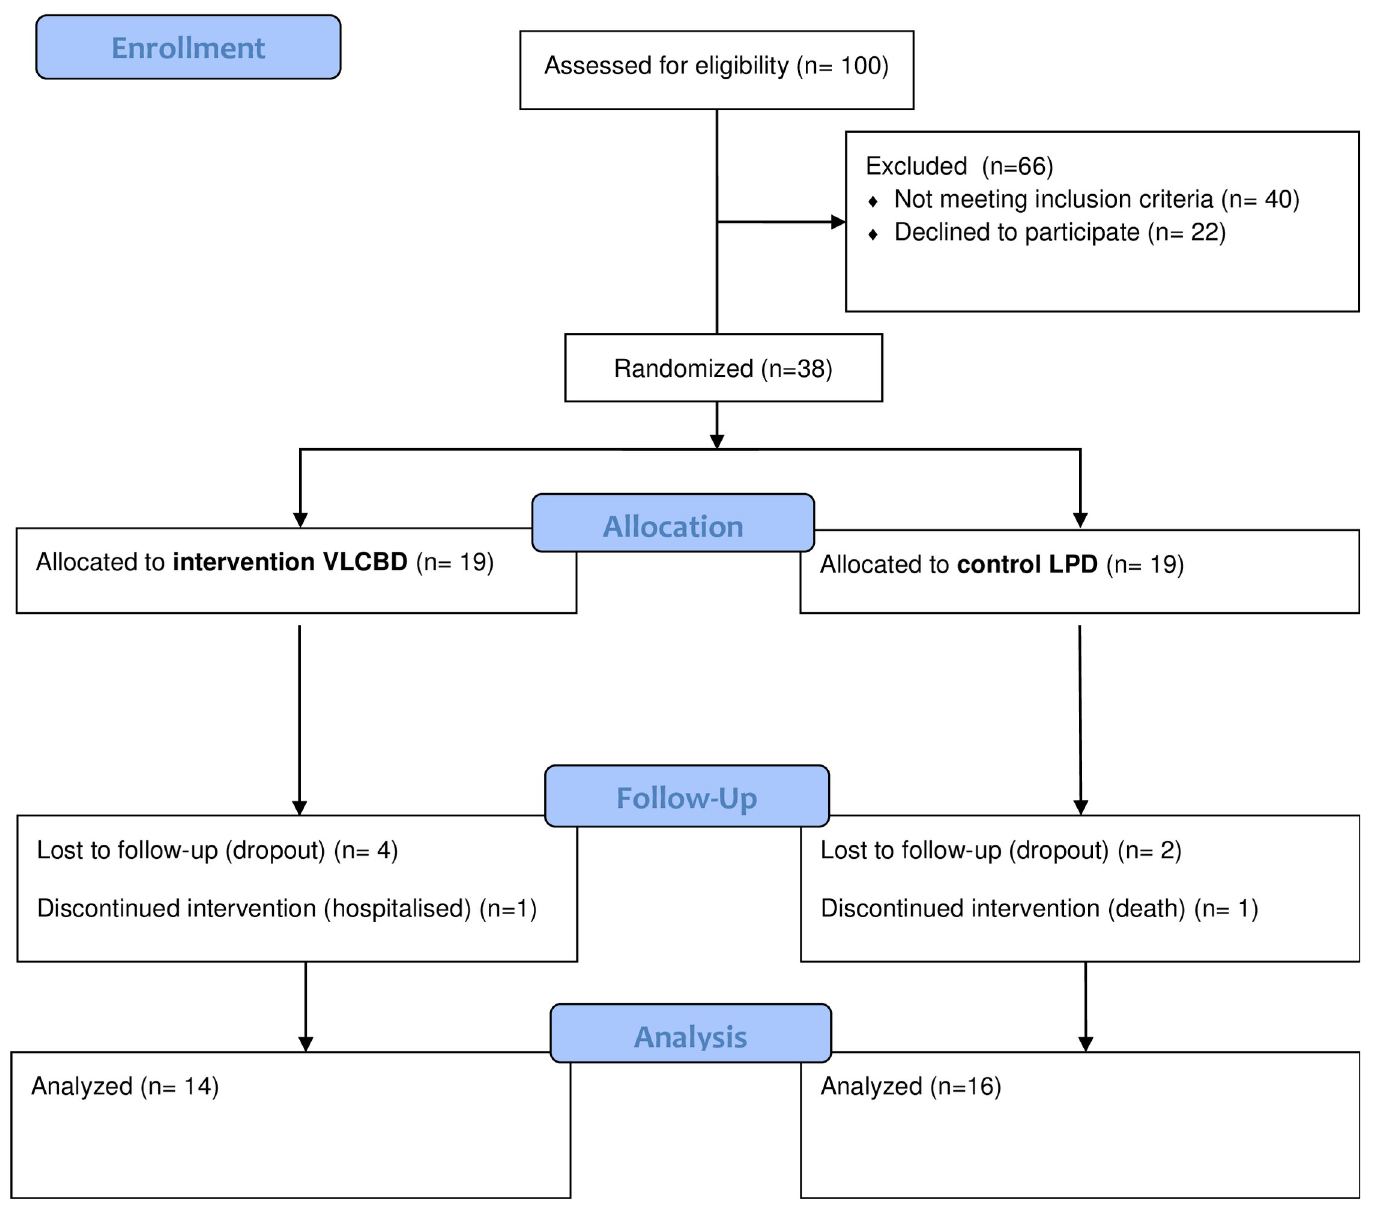
Fig 1. Flow diagram for the overall study